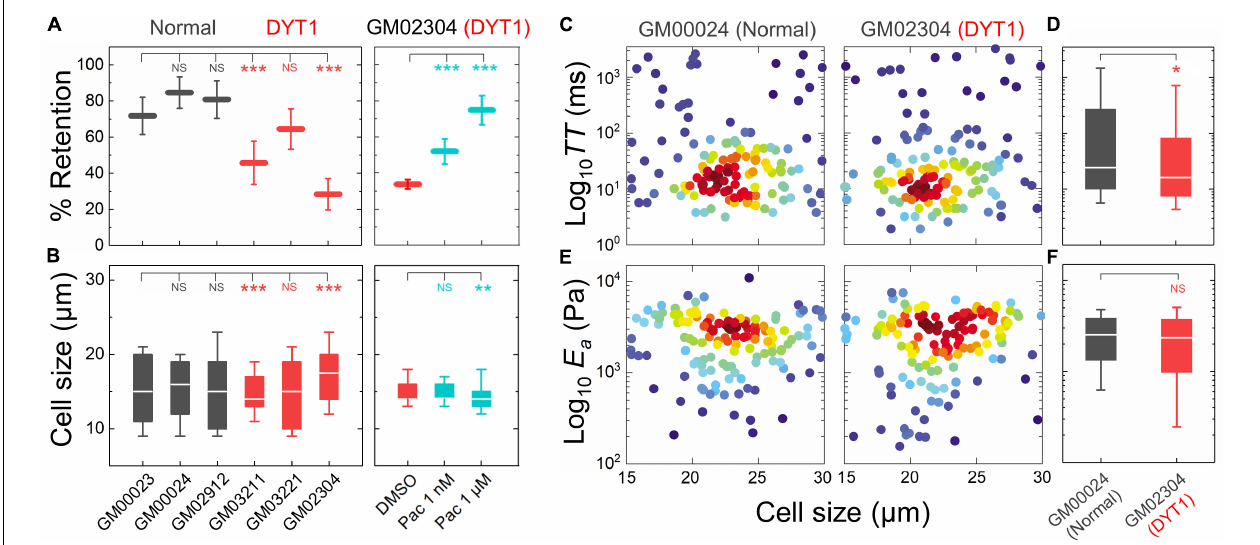
FIGURE 3 | DYT1 dystonia patient-derived fibroblasts have increased deformability compared to controls. (A) PMF measurements of normal and DYT1 dystonia patient-derived fibroblast lines. Paclitaxel (Pac) treatment for 24 h prior to filtration. PMF conditions: 10 µ m pore membrane, 1.4 kPa for 50 s. Each data point represents the mean ± SD. Statistical significance was determined using Student’s t -test. (B) Cell size data. Boxplots show 25 and 75th percentiles; line shows median; whiskers denote 10 and 90th percentiles. (C,E) Density scatter plots for TT and E a measurements determined by q-DC. Each dot represents a single cell. N > 190 per sample. (D,F) TT and E a measurement boxplots show 25 and 75th percentiles; line shows median; whiskers denote 10 and 90th percentiles. Statistical significance was determined using Student’s t-test. All data were obtained from three independent experiments. ∗∗∗ p < 0.001; ∗∗ p < 0.01; ∗ p < 0.05; and not significant (NS) p >